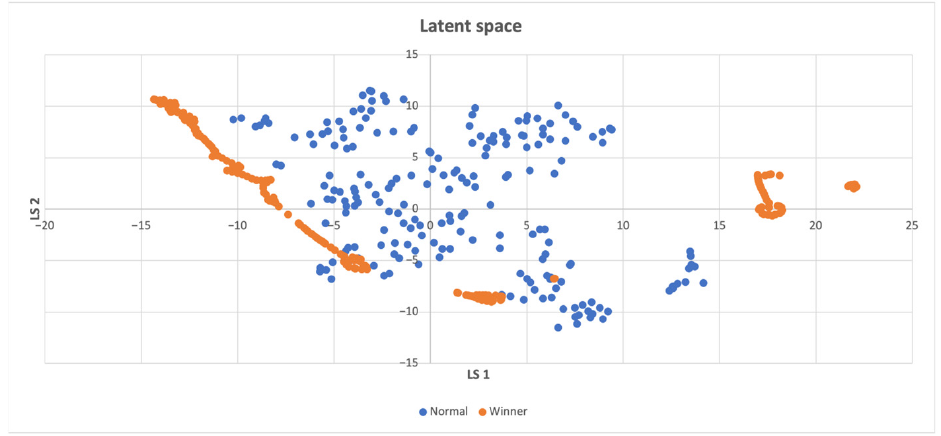
Figure 7. Latent space of the LunarLander-v2 environment, winning states and normal states are seldom close, which implies that unexplored states are crucial for accomplishing the task.